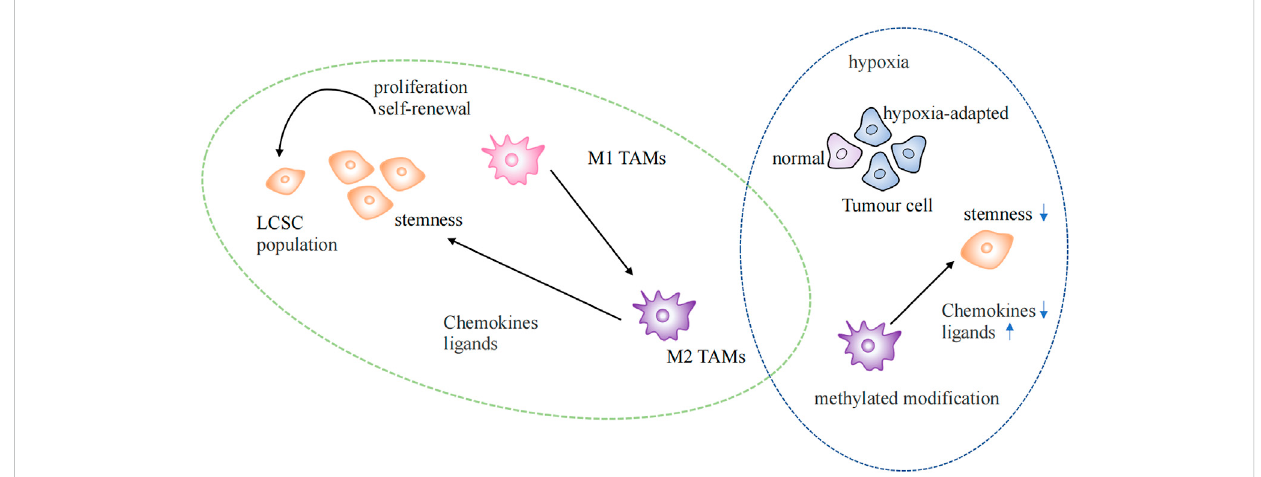
FIGURE 3 Epigenetic regulation in the tumor microenvironment. Regulation of lung cancer stem cells by TAMs of the M2 phenotype in normal and hypoxic environments. LSCS: lung cancer stem cell; TAMs: Tumor-associated macrophages.